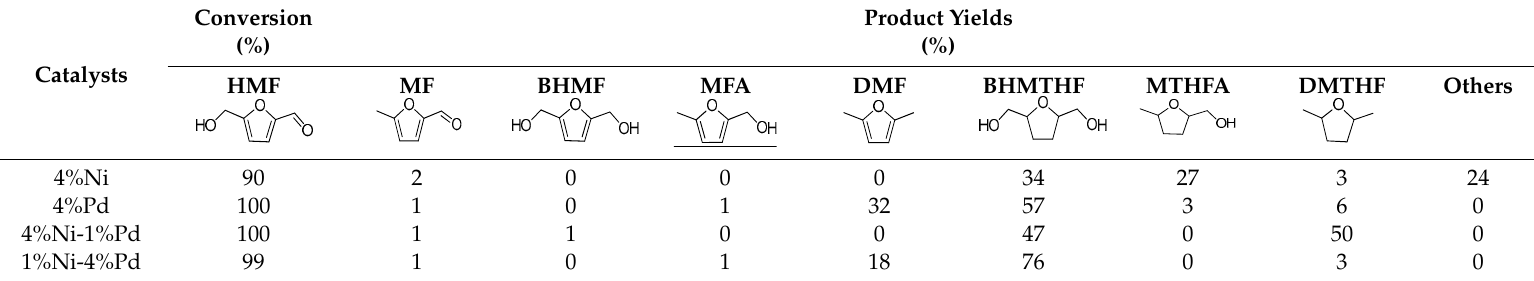
Table 4. The activity of monometallic and bimetallic Ni-Pd / γ -Al 2 O 3 catalysts in the HMF hydrogenation, expressed in terms of HMF conversion and of the di ff erent product yields.